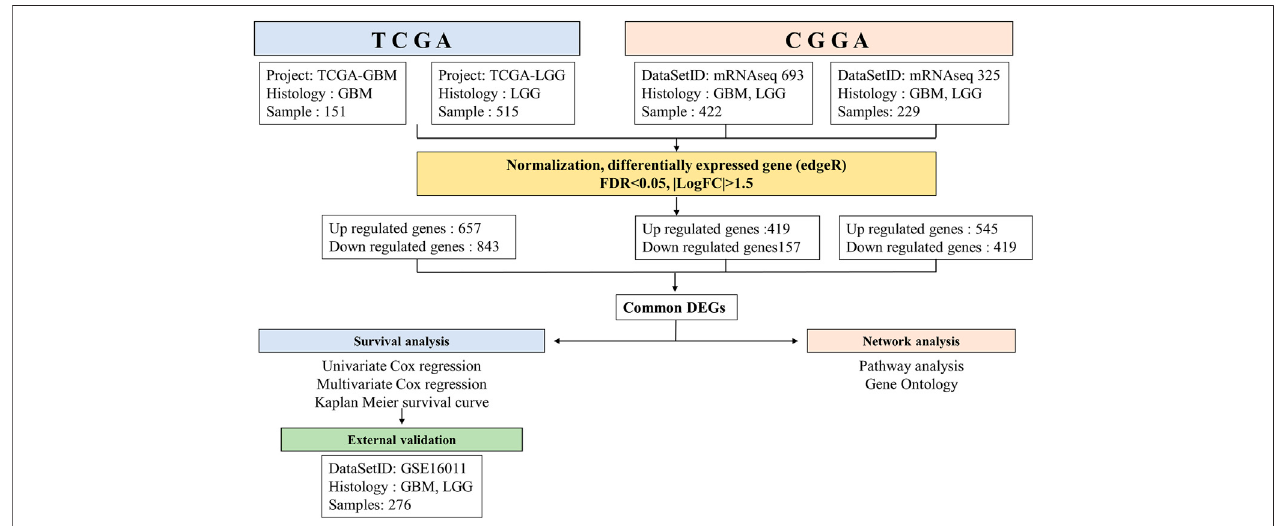
FIGURE 1 | Work fl ow of gene expression analysis of RNA-seq datasets TCGA and CGGA. Each datasets were run through the pipeline individually, then selected common DEGs between GBM and LGG.